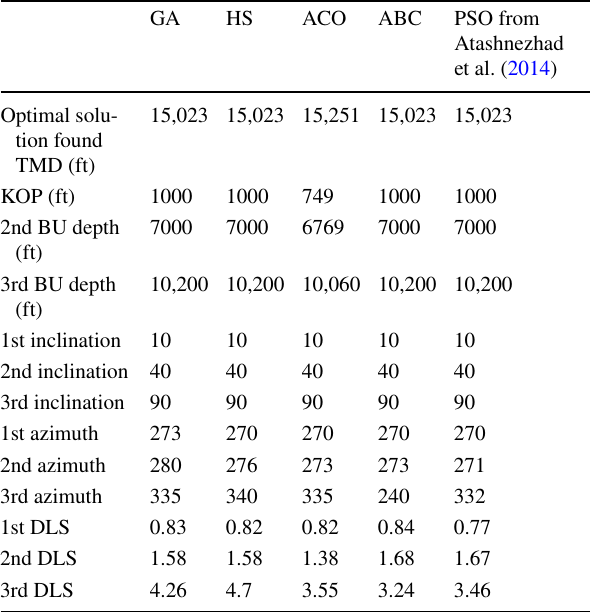
Atashnezhad et al. (2014)